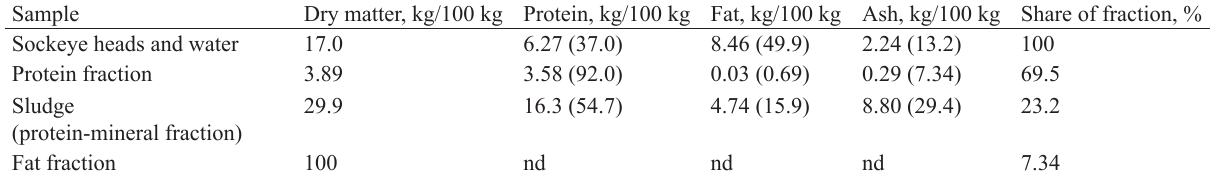
Table 2 Chemical composition of raw materials and fractions obtained after thermal hydrolysis of sockeye heads Sample